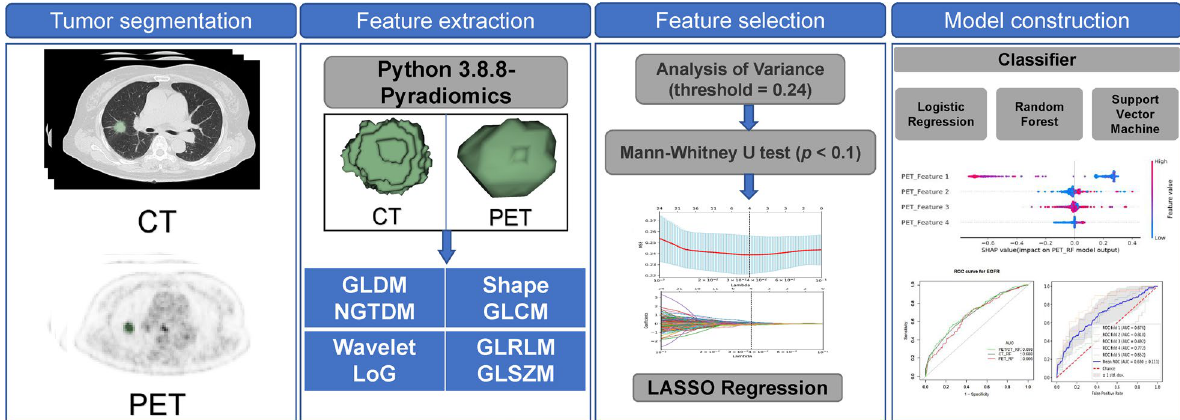
Fig. 2 Flow chart of radiomics